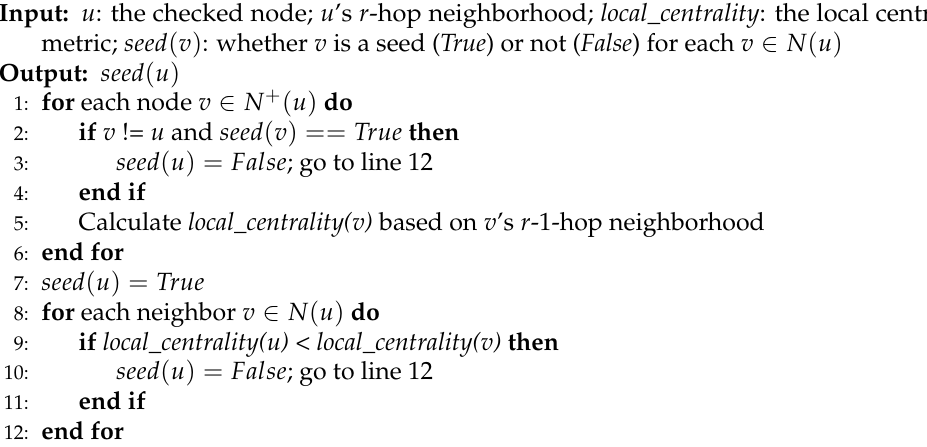
Algorithm 1 The local seeding